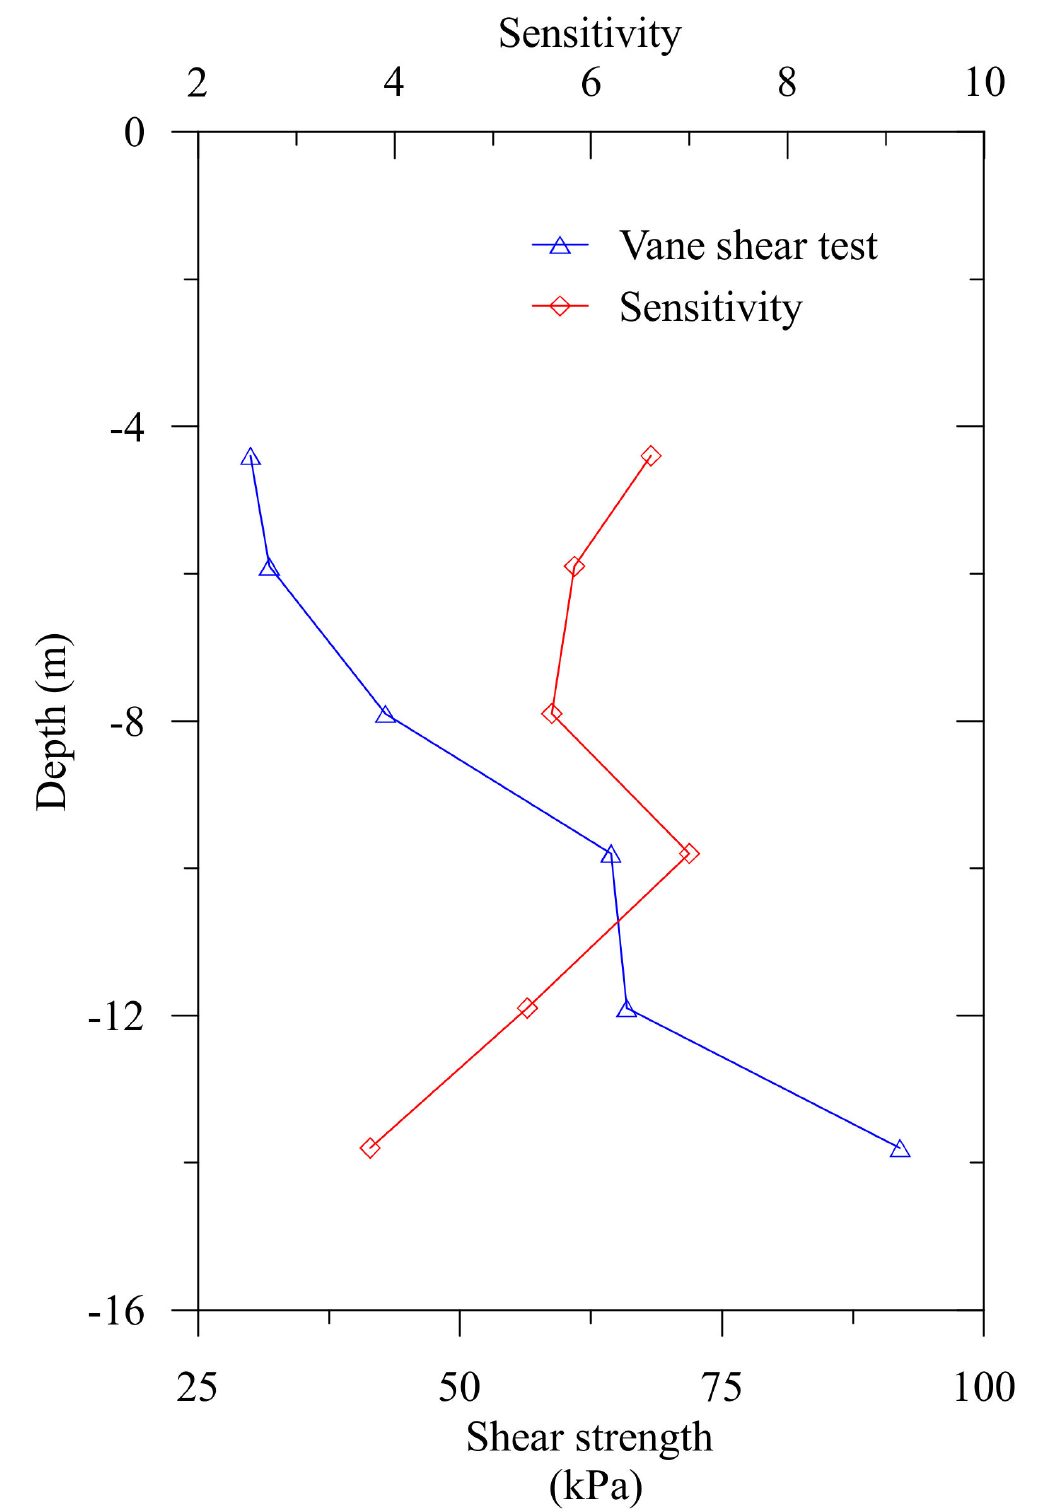
Figure 10. Undrained shear strength and sensitivity of the embankment’s foundation soil. A comparison of the measured sensitivity of the NBR embankment foundation clay and the CPT interpreted values are demonstrated in Figure